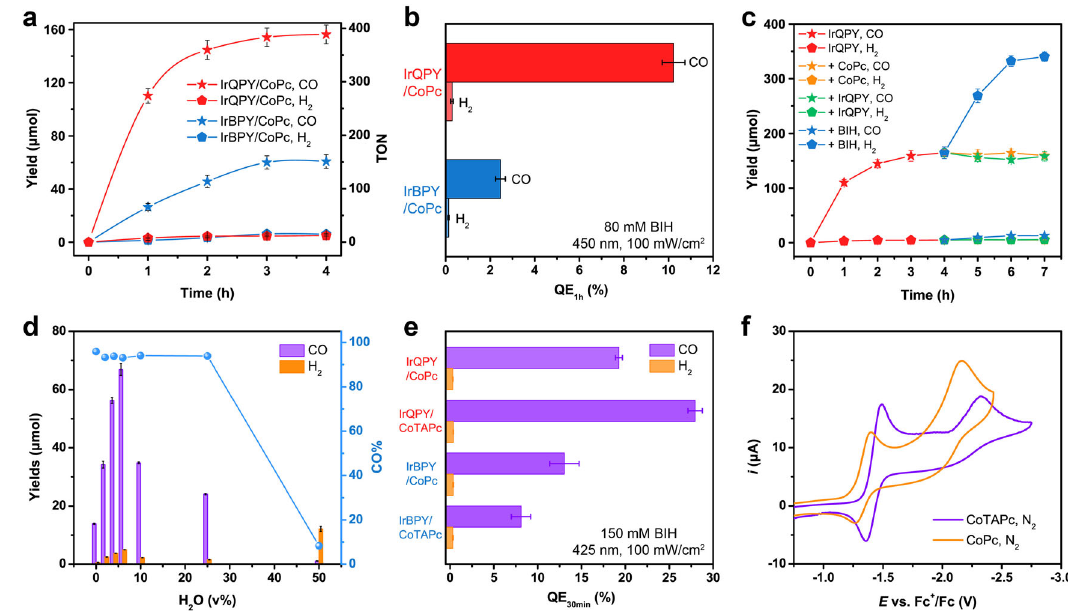
Fig. 3 Photocatalytic CO 2 reduction. a Time pro fi les of photocatalytic CO (star) and H 2 (pentagon) formation with IrQPY/CoPc (red) or IrBPY/CoPc (blue) system. b QEs for CO and H 2 formation from IrQPY/CoPc (red) and IrBPY/CoPc (blue) systems. c Time pro fi les of photocatalytic CO (star) and H 2 (pentagon) formation from IrQPY/CoPc (red) system. After 4 h, fresh CoPc (0.4 µ mol, orange), IrQPY (0.4 µ mol, green), or BIH (32 µ mol, blue) was dispersed in 0.5 mL CO 2 -saturated CH 3 CN and injected into the solution, respectively. d Photocatalytic CO (violet) and H 2 (orange) yield with IrQPY/CoPc and varying volumes of H 2 O, and corresponding CO% are shown (blue circle). e QEs for CO (violet) and H 2 (orange) formation from IrQPY/CoPc, IrBPY/ CoPc IrQPY/CoTAPc, and IrBPY/CoTAPc systems with 150 mM BIH and 425 nm light within 30 min. f CVs of CoPc (orange) and CoTAPc (violet) under N 2 . The error bars in the plots represent the standard deviations of three independent